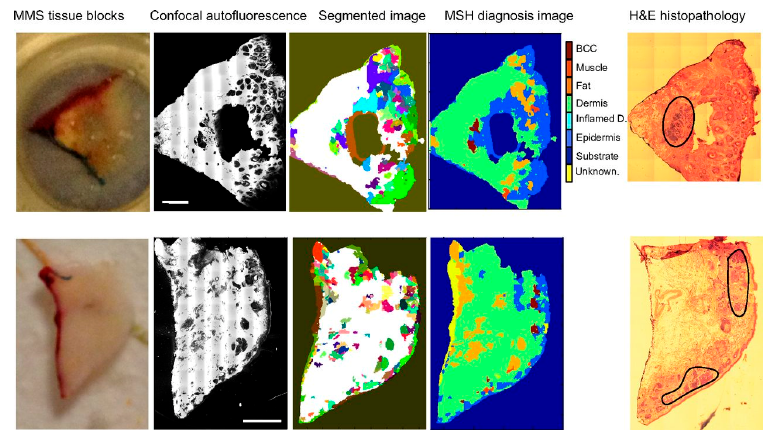
Figure 1. Multimodal Spectral Histology (MSH) diagnosis of BCC in unsectioned tissue blocks as received from surgery. H&E histopathology images for adjacent sections are included for comparison. (Scale bars: 2 mm.) Figure reproduced from Kong et al., [28].